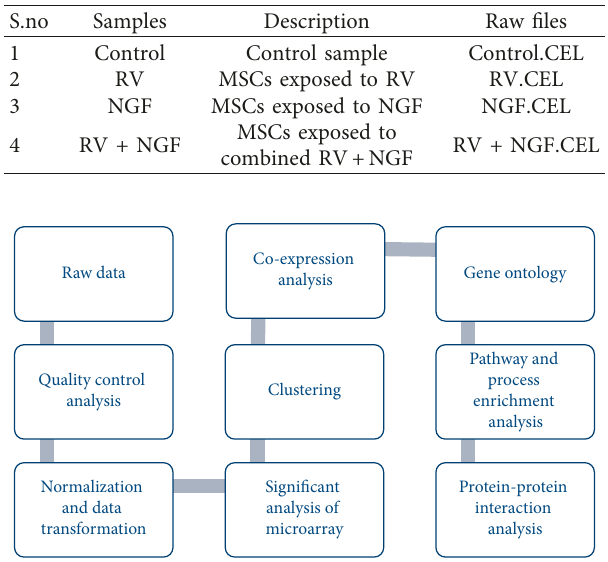
Figure 1: Workflow used for microarray data analysis and